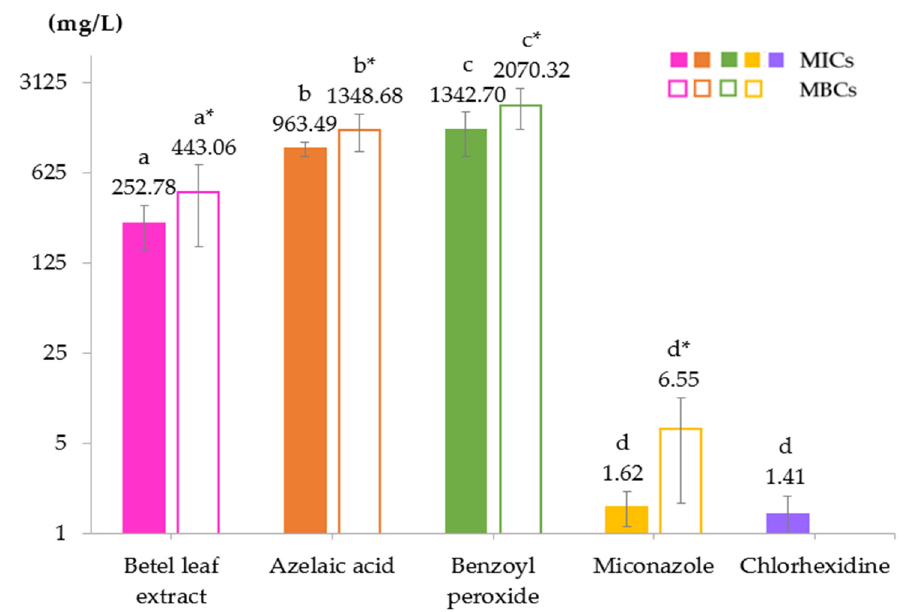
Figure 1. Minimum inhibitory concentrations (MICs) and minimum bactericidal concentrations (MBCs) of Piper betle leaf extract, azelaic acid, benzoyl peroxide, miconazole, and chlorhexidine against 75 Staphylococcus clinical isolates of canine pyoderma. Only chlorhexidine’s MIC was determined in 39 Staphylococcus isolates, and its MBC was not determined. Data were expressed as means and standard deviations. a, b, c, d Above mean MIC bars and a*, b*, c*, d* above mean MBC bars carrying different superscripts are significantly different by Kruskal–Wallis one-way ANOVA ( p < 0.0001).